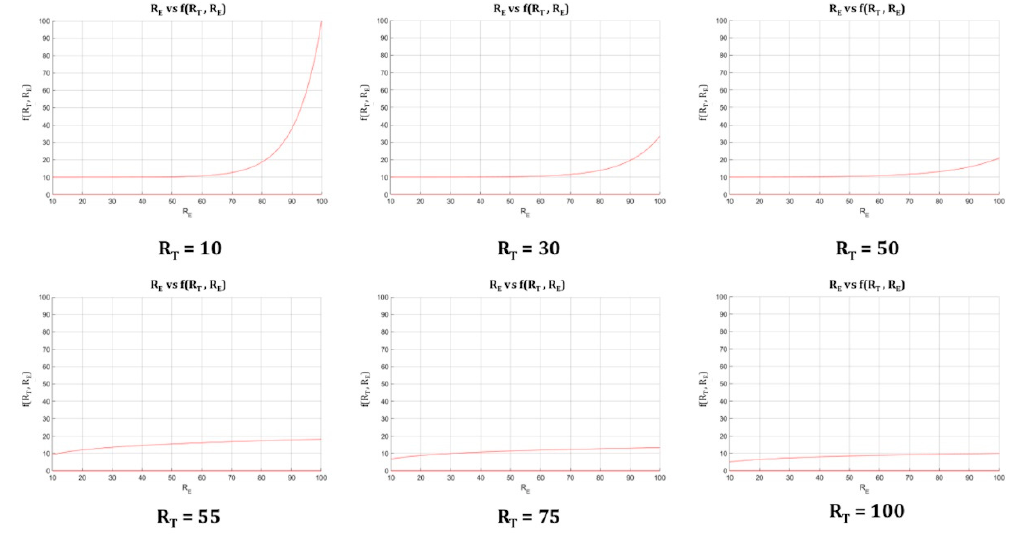
Figure 9. Fundamental curves: Expert Risk vs. Decision Factor for different Technical Risk values.